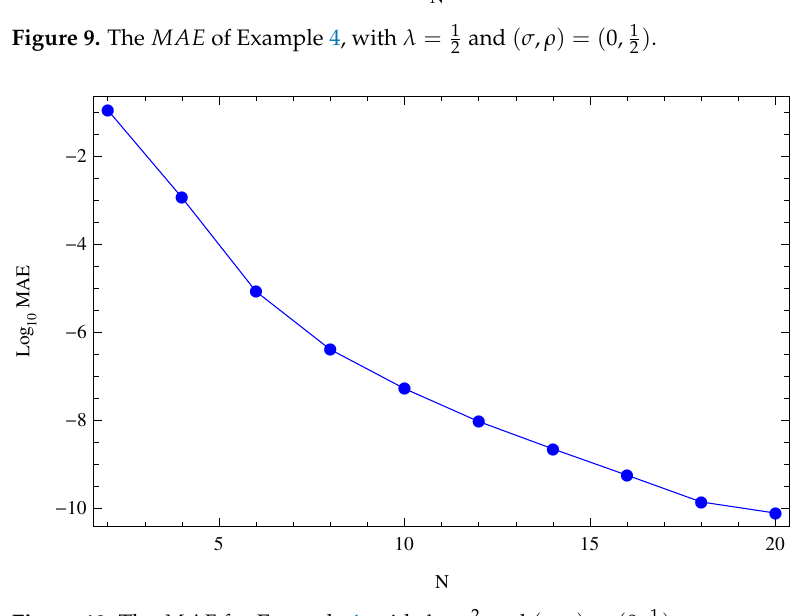
Figure 10. The MAE for Example 4, with λ = 2